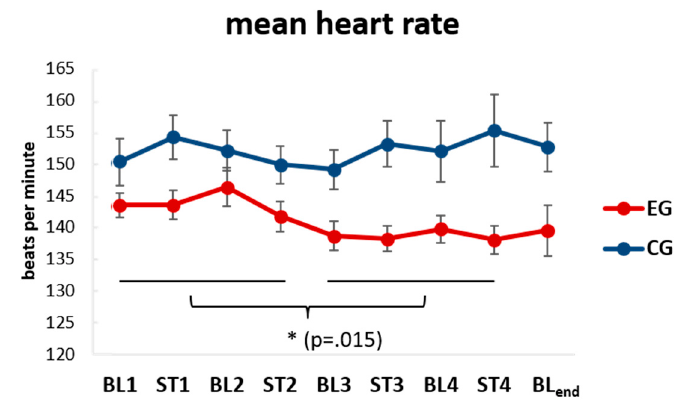
Figure 3. Evolution of the heartrate (HR) over time. The two timelines show the mean HR for the four chronologically ordered baseline (BL 1,2,3,4 ) and stimulation (ST 1,2,3,4 ) periods of 3 min each independent of rhyme and voice familiarity. Note that infants familiar (EG) and unfamiliar (CG) with prenatal stimulation show distinct HR. Especially in the second part the EG seems to show habituation and deceleration of the HR as revealed by paired-sample t-tests. Data is pooled from the same babies recorded twice at week two and week five of age. BL end refers to the last 3 min baseline following four baseline and stimulation periods. * = statistical significance p < 0.05; Error bars = ±1 SEM.